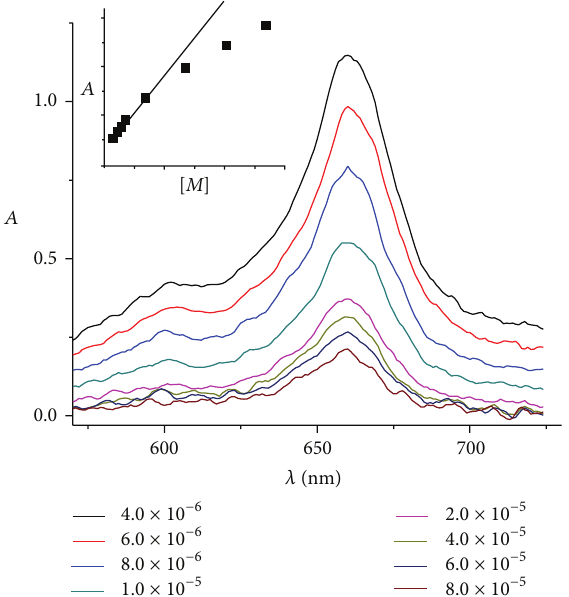
Figure 4: UV-Vis spectrum of CoPc in DMF with different concen- tration (mol/L) (the inset is the relationship between the absorbance at maximum absorption wavelength and the concentration).